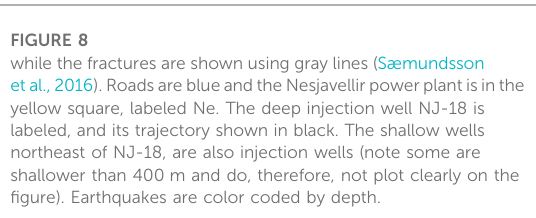
FIGURE 8 Relocatedseismicityusedinthe3Dvelocitymodels.Mapand cross-section of the relocated seismicity of the Nesjavellir geothermal fi eld and surroundings. The inverted orange triangles are the well heads and the diamonds show the seismic stations. Orange lines in the cross-sections are borehole trajectories. Red lines represent the eruptive fi ssure and craters,